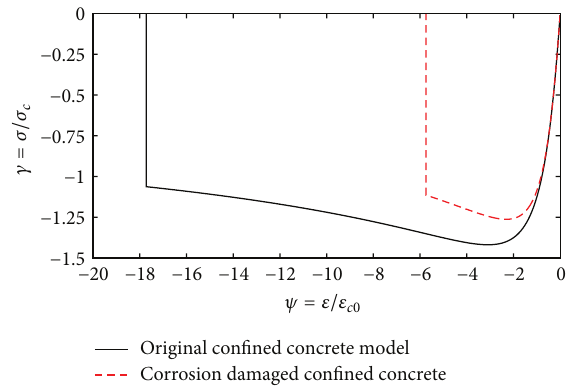
Figure 6: Corrosion damaged confined concrete model (20% mass